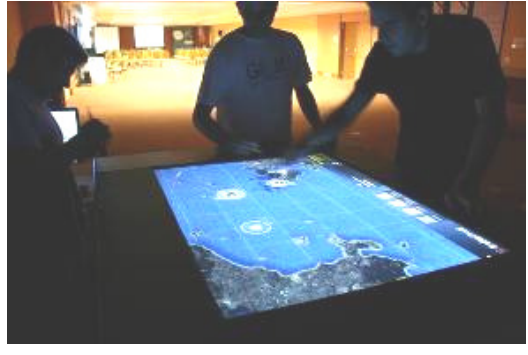
Figure 4. Developed multi-touch